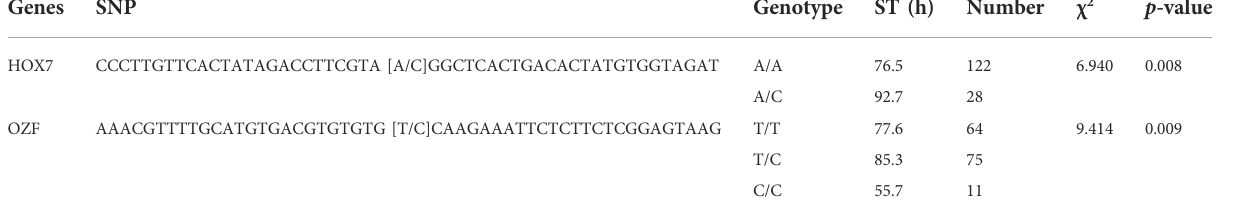
TABLE 4 Association analysis result of SNPs in the genes HOX7 and OZF.